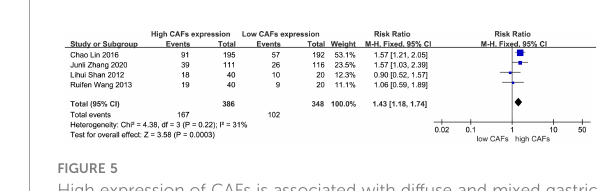
FIGURE 5 High expression of CAFs is associated with diffuse and mixed gastric